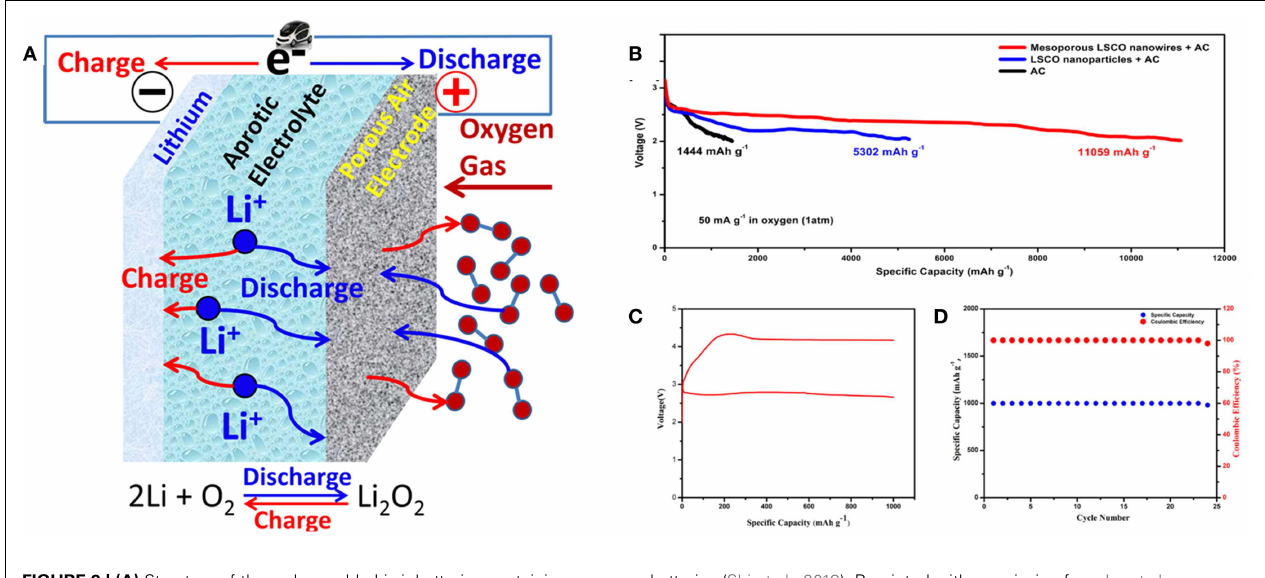
FIGURE 8 | (A) Structure of the rechargeable Li-air batteries containing a catalyst (Lu et al., 2014). (B) Discharge curve of Li-air batteries. (C,D) Charge/discharge curve and cycling performance of Li-air